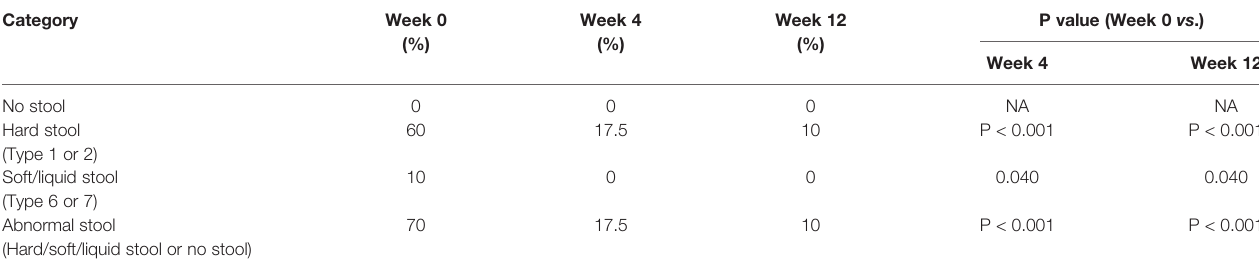
TABLE 2 | The percent of stool style of ASD is based on the daily stool record and the Bristol Stool Form Scale (p valve by two-tailed c 2